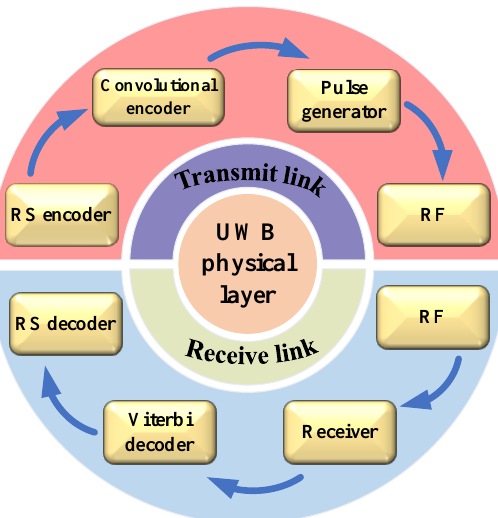
Figure 1. Structure of UWB physical layer.